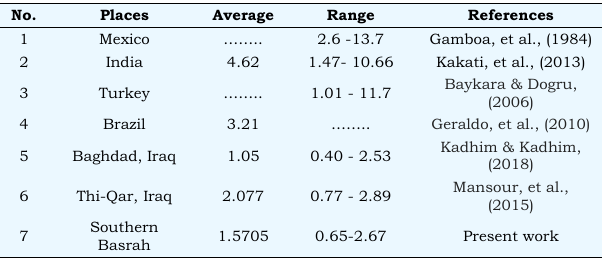
Table 2 Comparison between the current work's uranium content (ppm) and the other sites